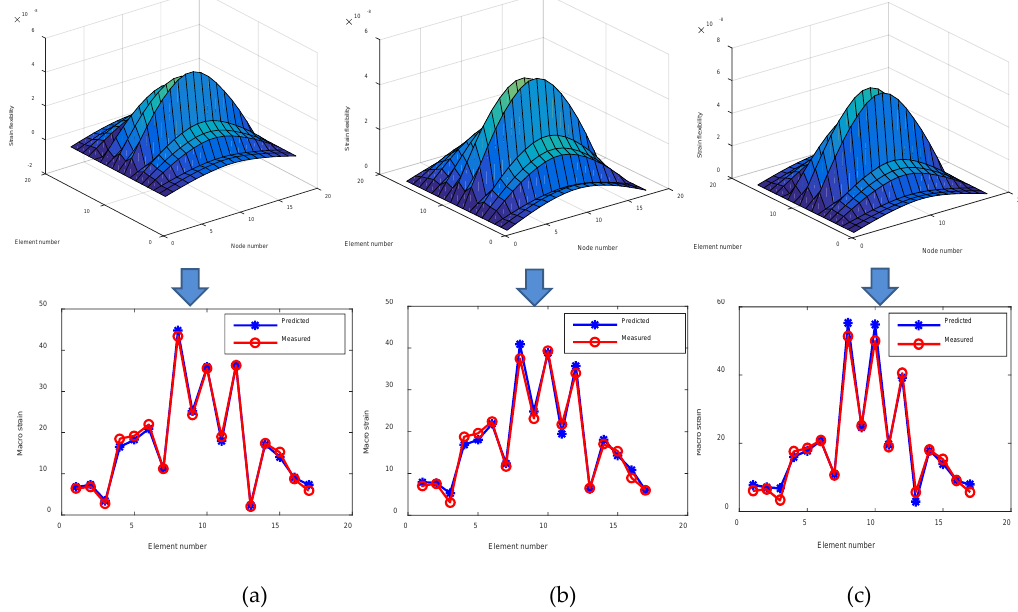
Figure 9. Strain flexibility and static strain prediction for intact structures. ( a ) Intact structure; ( b ) Case 1; ( c ) Case 2.